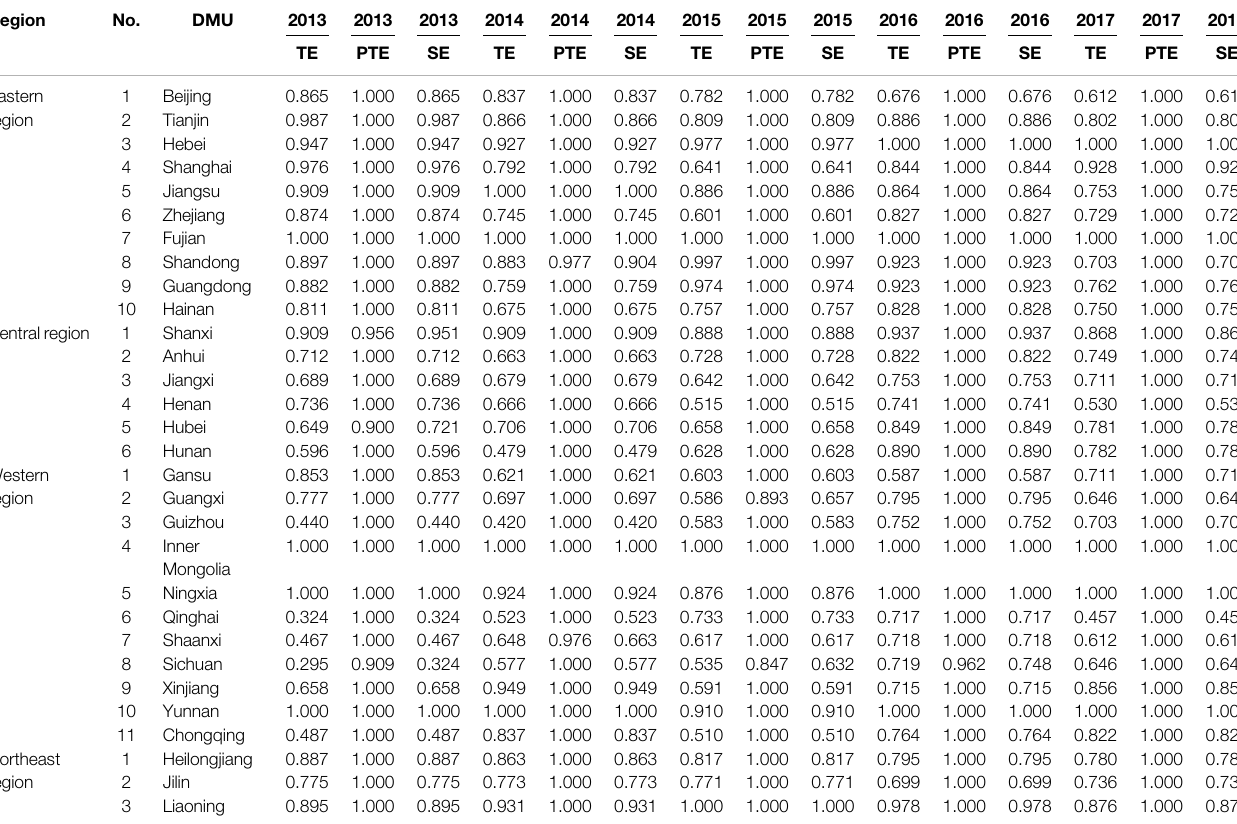
TABLE 5 | 2013 – 2017 Decomposition of technical ef fi ciency score. Region